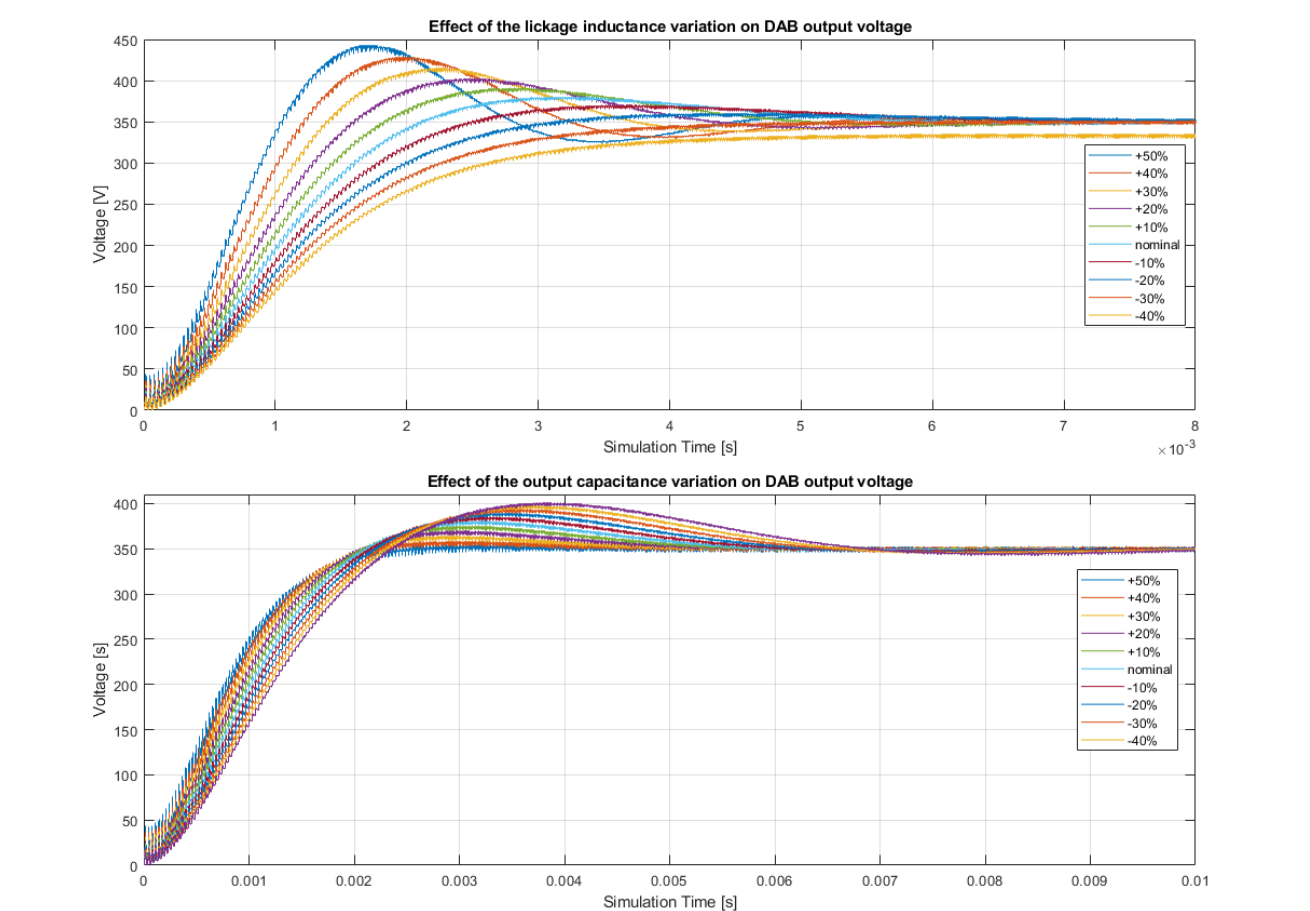
Figure 25. Effect of the transformer primary side inductance ( top ) and output capacitor ( bottom ) variances on the voltage control in the DAB